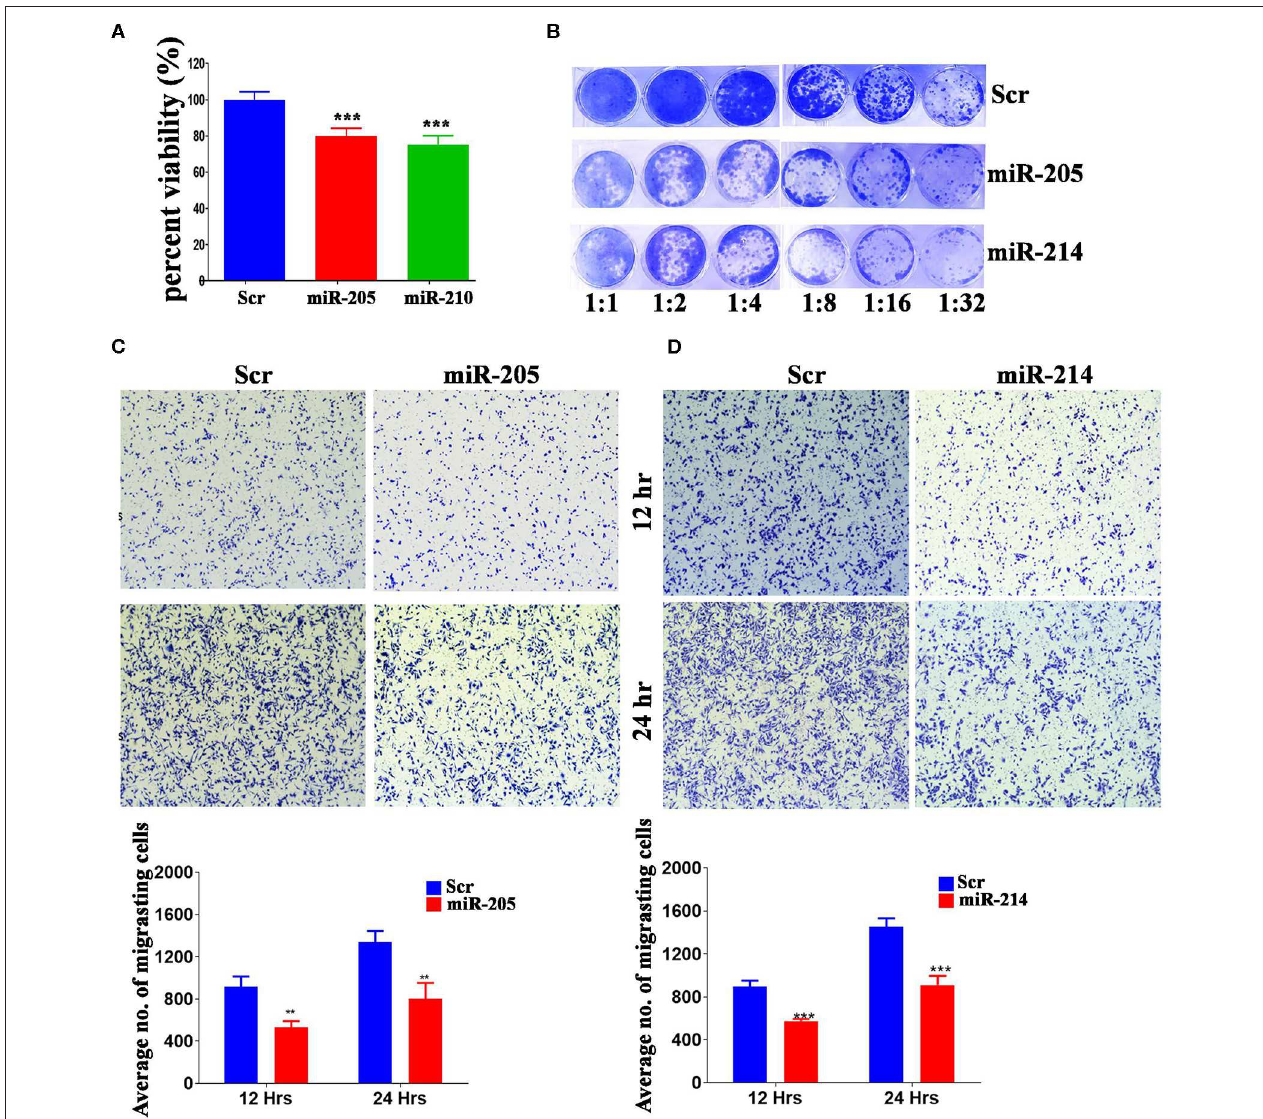
FIGURE 3 | MiR-205-5p and miR-214-3p inhibits MDA-MB-231 BC cell proliferation, colony formation and migration. (A) Cell viability of MDA-MB-231 cells transfected with hsa-miR-205, hsa-miR-214-3p, or scrambled-control measured on day 5 using alamarblue assay. Data are presented as mean ± S.E.M., n = 6. (B) Clonogenic assay showing the colony forming capability of MDA-MB-231 cells transfected with hsa-miR-205, hsa-miR-214-3p, or scrambled-control. Plates were stained with Diff-Quik stain set on day 10. Wells are representative of two independent experiments for each condition. (C,D) Migration capability of MDA-MB-231 cells transfected with hsa-miR-205, hsa-miR-214-3p compared to scrambled-control. The two-tailed t -test was used to compare different treatment groups. ** p < 0.01; *** p <